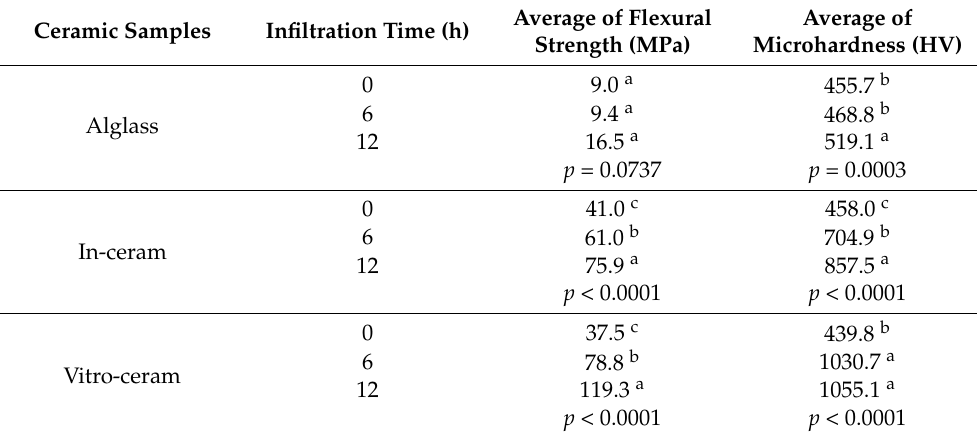
Table 6. Comparison of average flexural strength and microhardness of independent samples using Tukey test at 5% probability level. Ceramic